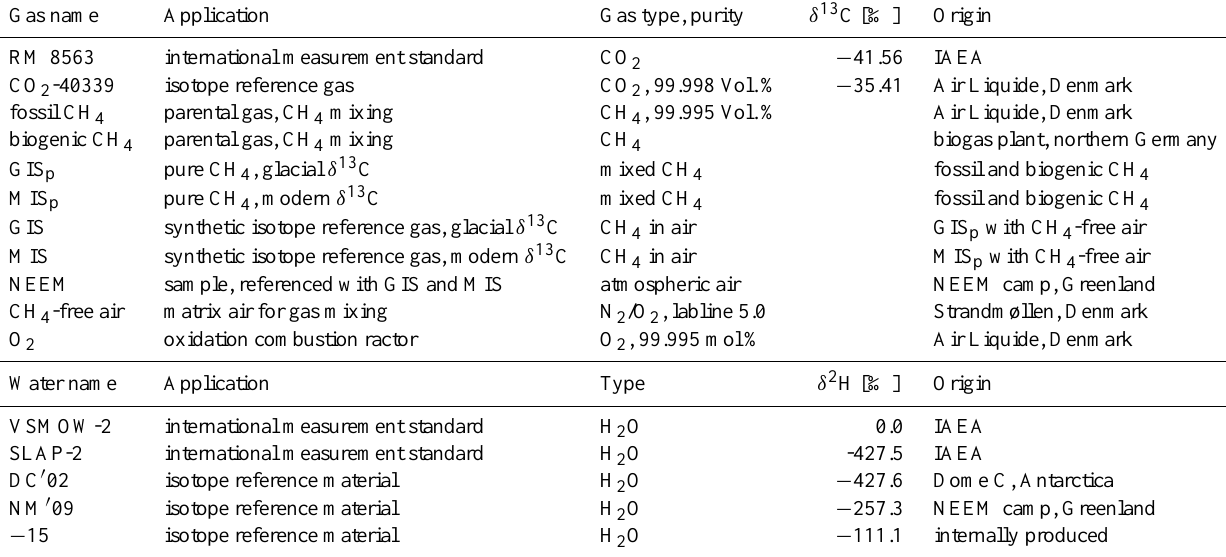
Table 1. Overview of gases and waters. All gases used for measuring, mixing and referencing are mentioned in the top panel, the bottom panel displays all waters that were used to reference the δ 2 H-CH 4 . The application and reference path of each measure are described in the second column while the third column informs on material type and purity level if applicable. The fourth column shows the relevant isotope ratios of applied reference material, the fifth column identifies the distributor of materials or specifies the origin of the measure if not commercially